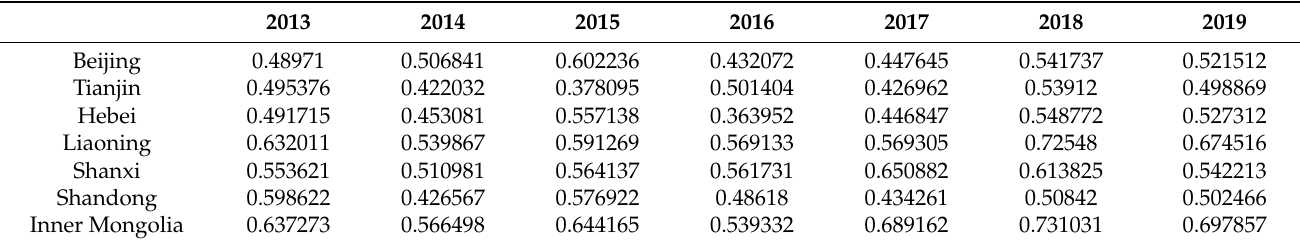
Table 11. Comprehensive evaluation results of psychological